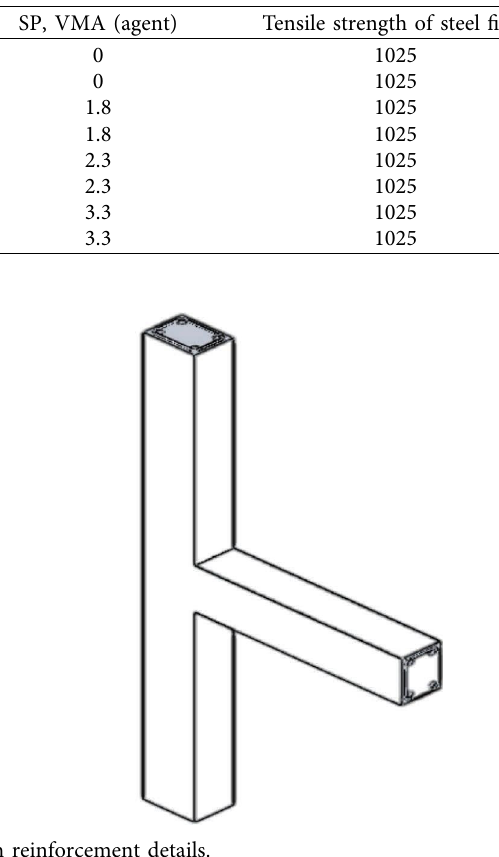
Table 1: Specimen details.